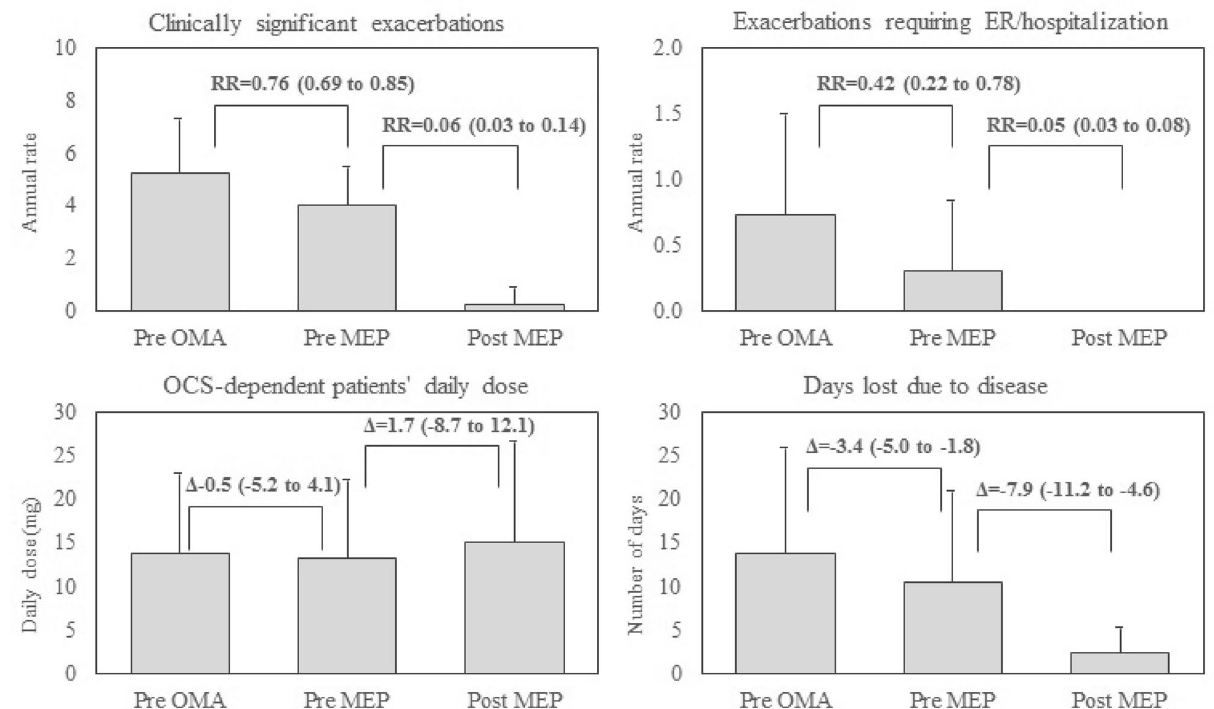
Figure 1. Pre-OMA, pre-MEP and post-MEP clinical evolutions in clinically significant exacerbation (top- left), exacerbations requiring ER or hospitalization (top-right), daily dose of OCS in OCS-dependent patients (bottom-left), and number of days lost due to the disease (bottom-right). Bars represent mean values, error bars represent standard deviations, and relative measures were expressed as mean (95% confidence interval). Δ mean difference, ER emergency room, MEP mepolizumab, OMA omalizumab, OCS oral corticosteroids, RR rate ratio.